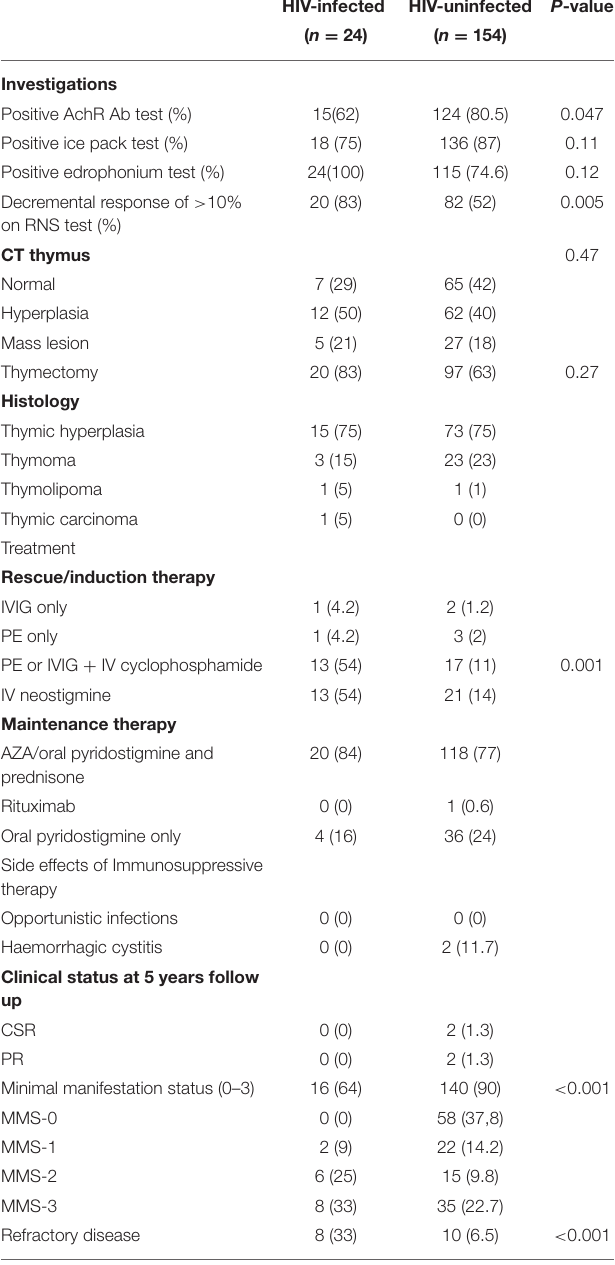
TABLE 3 | Investigations, treatment and clinical status at follow up in the HIV-infected and HIV-uninfected